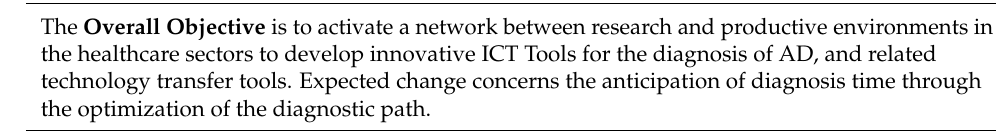
Table 1. The ITAMA